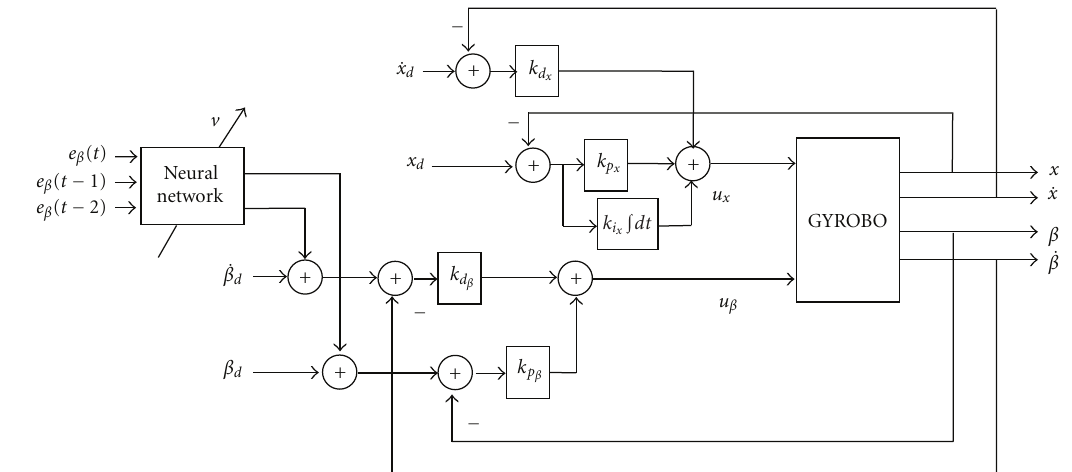
Figure 6: RCT neural network control structure.